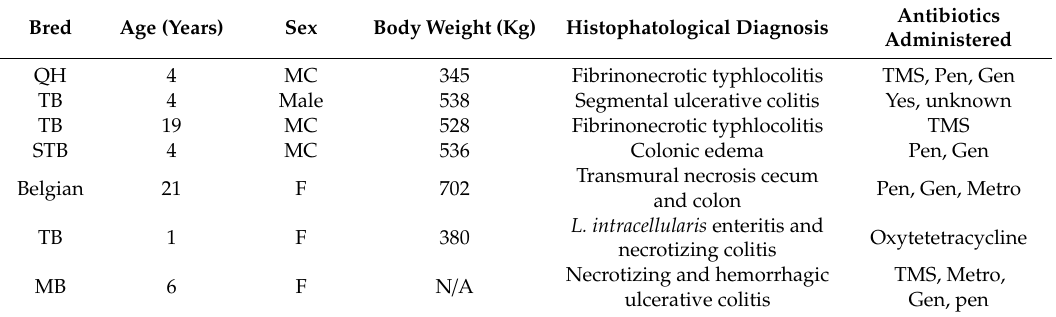
Table 1. Signalment, histopathological diagnosis and antimicrobials administered to colitis